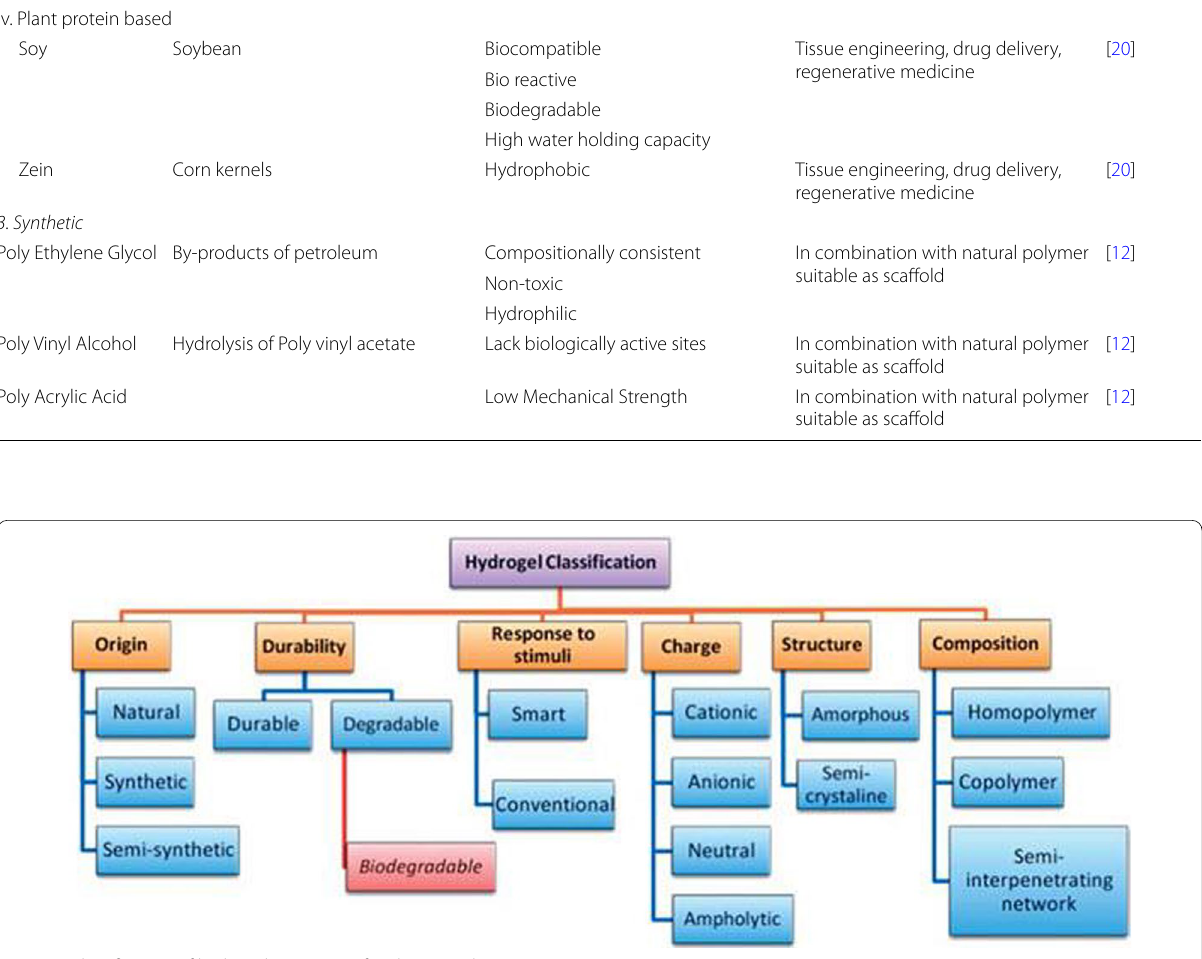
Fig. 1 Classification of hydrogel. Courtesy of Malpure et al. [65]